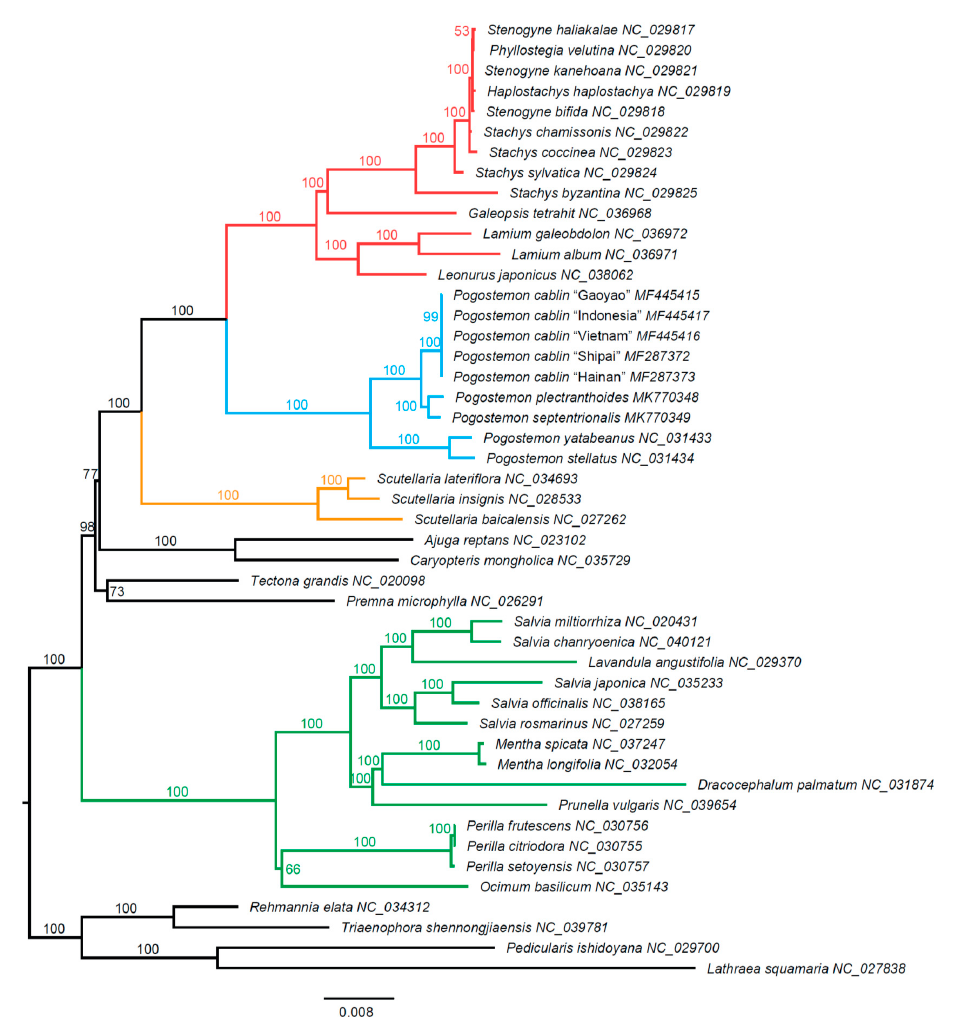
Figure 5. Maximum likelihood tree of 43 Lamiaceae accessions and four outgroups inferred from a concatenated codon supermatrix of 80 chloroplast protein-coding genes with a best partition scheme. Red clade: Stachydeae + Galeopsis + Lamieae + Leonureae, blue clade: Pogostemon , yellow clade: Scutellarioideae, and green clade: Nepetoideae. The group including red and blue colors is the Lamioideae. Numbers on the branches are bootstrap support values.